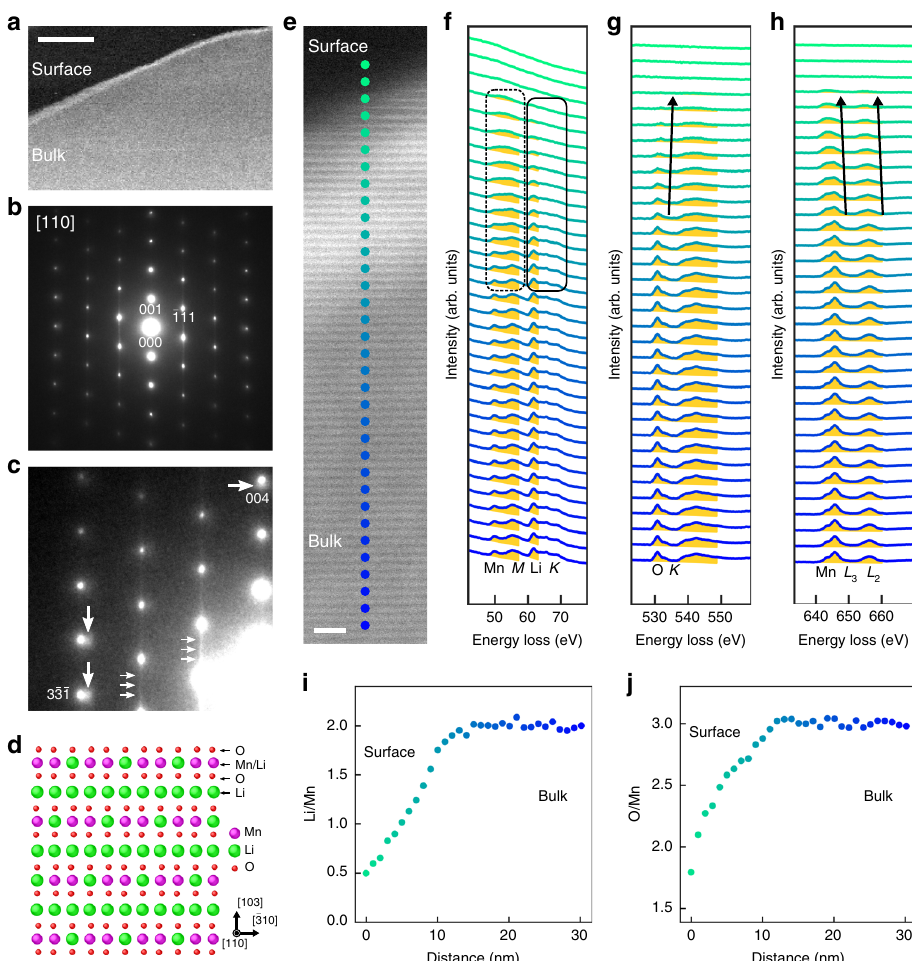
Fig. 1 Determination of local chemical composition in delithiated Li 2 MnO 3 . a LAADF-STEM image and b corresponding electron diffraction pattern obtained from a partially delithiated Li 2 MnO 3 single crystal. c Magni fi ed electron diffraction pattern of b , where the contrast is intentionally enhanced. d The structure of Li 2 MnO 3 , viewed along the [110] direction (the notation is based on the monoclinic crystal system). e LAADF-STEM image obtained from the partially delithaited sample. f – h The EEL spectra obtained from the locations indicated by the circles in e : f Mn- M , Li- K edges, g O- K edge, h Mn- L 2,3 edges, respectively. i , j The atomic ratios of Li/Mn and O/Mn calculated from the integrated intensities as a function of distance in f in a and e are 100 and 2 nm,